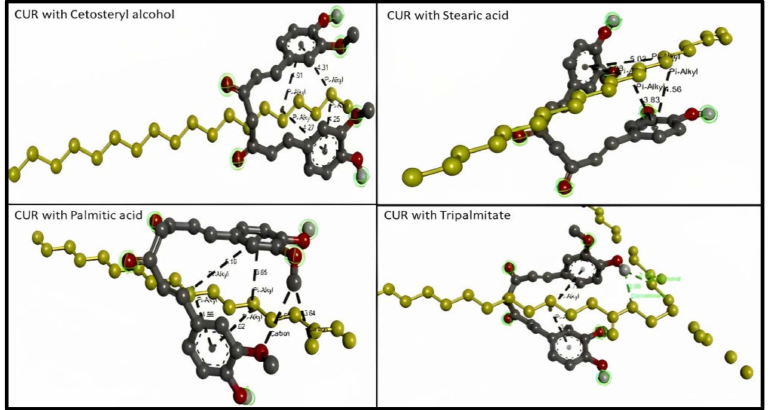
Figure 3. 3D molecular interaction between curcumin (CUR) with different solid lipids (highlighted in yellow) for solubility prediction. The formed bonds are described as black short lines.